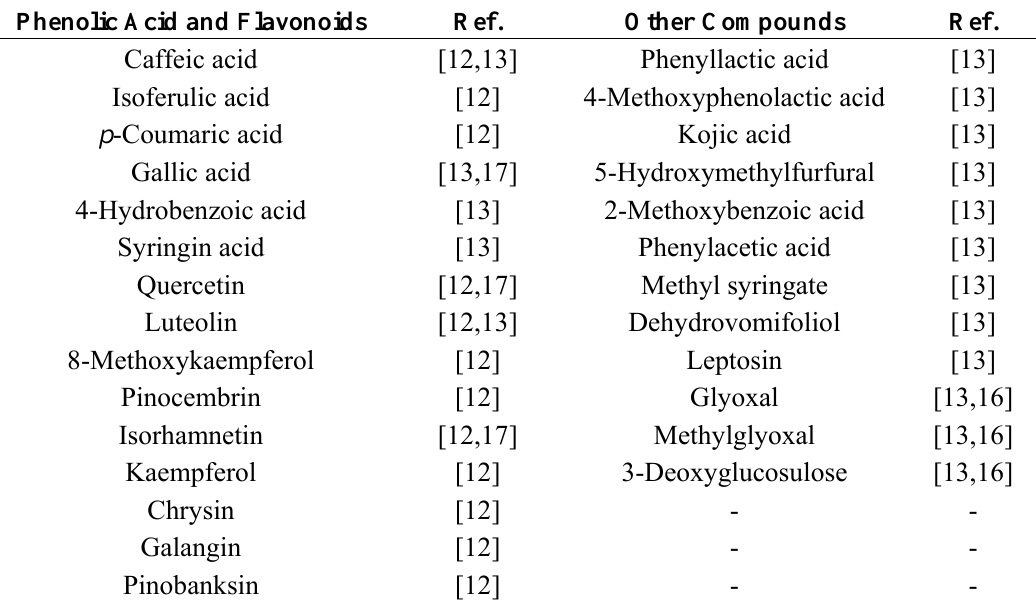
Table 1. Most common compounds identified in manuka honey. Phenolic Acid and Flavonoids